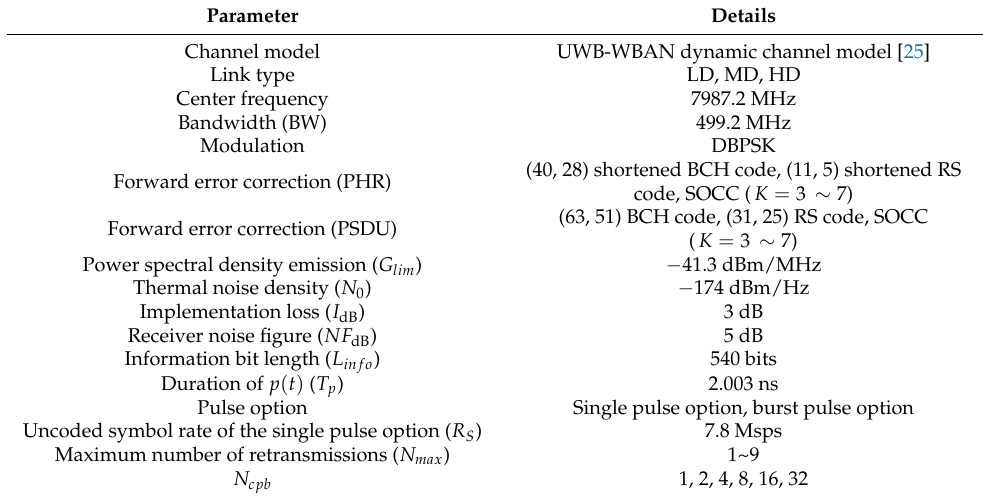
Table 4. Computer simulation parameters. Parameter